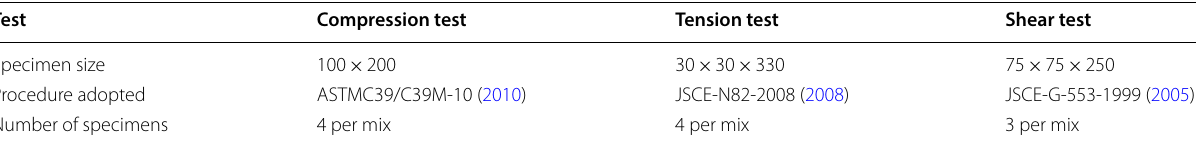
Table 4 Mechanical test